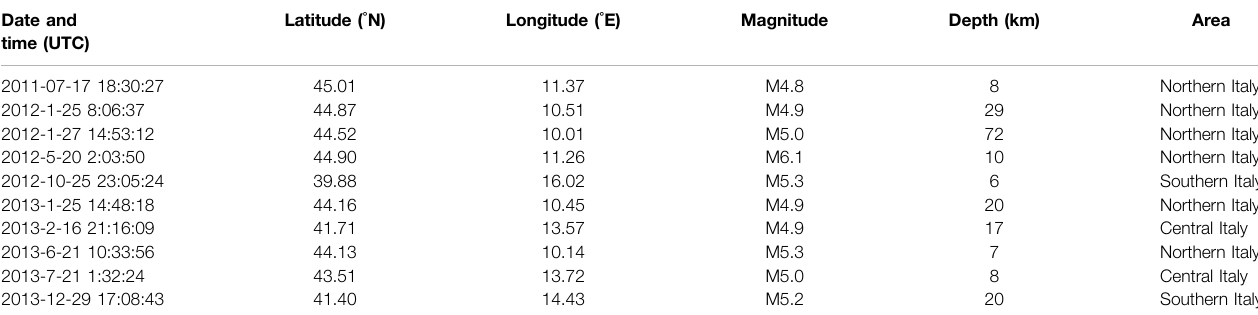
TABLE 2 | Earthquakes in 2010 – 2013 with M ≥ 4.7 in the land area of Italy. Date and time (UTC)